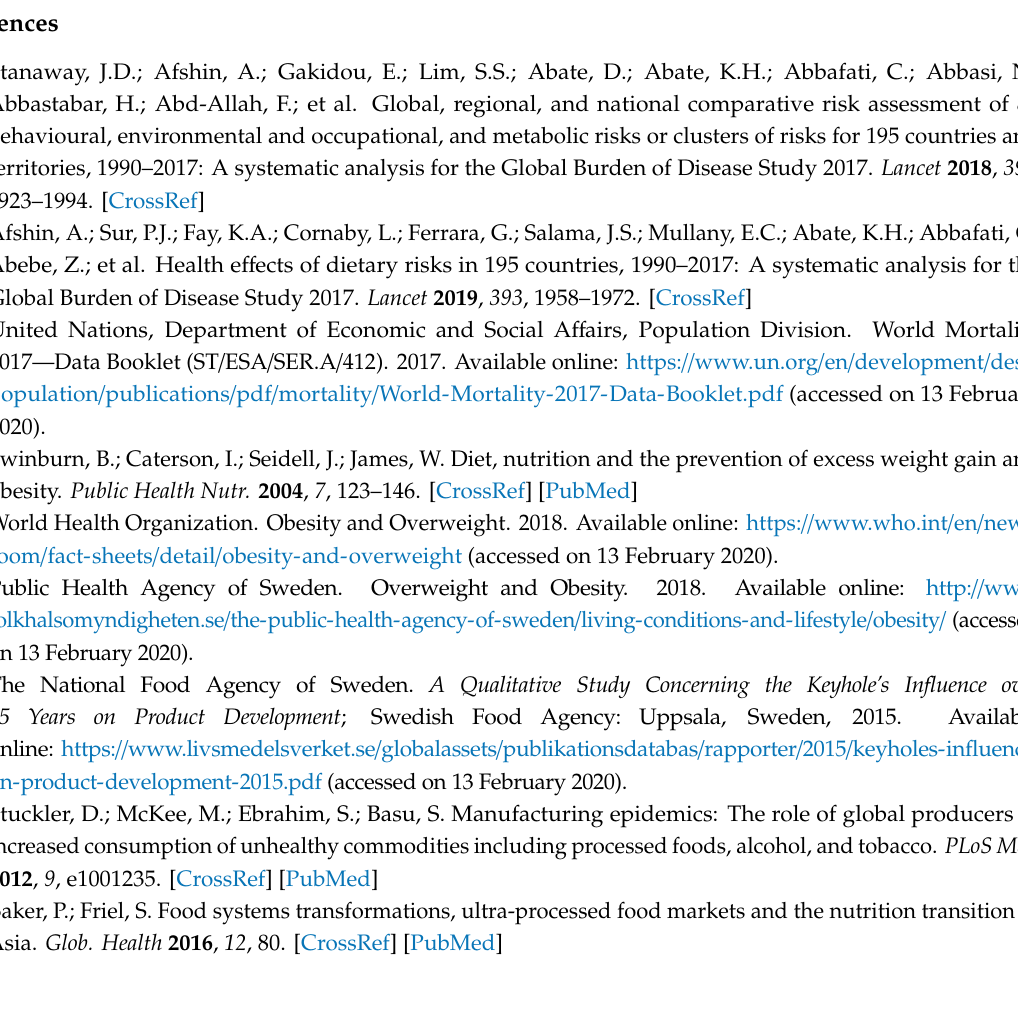
Table S1: The six di ff erent food categories in the Health Star Rating (HSR) system, Table S2: Health Star Rating (HSR) Baseline Points for Category 1, 1D, 2 or 2D Foods, Table S3: Health Star Rating (HSR) Protein, Fiber and Fruit / Vegetable / Nuts / Legumes Points, Table S4: Final scores used to assign Heath Star Ratings